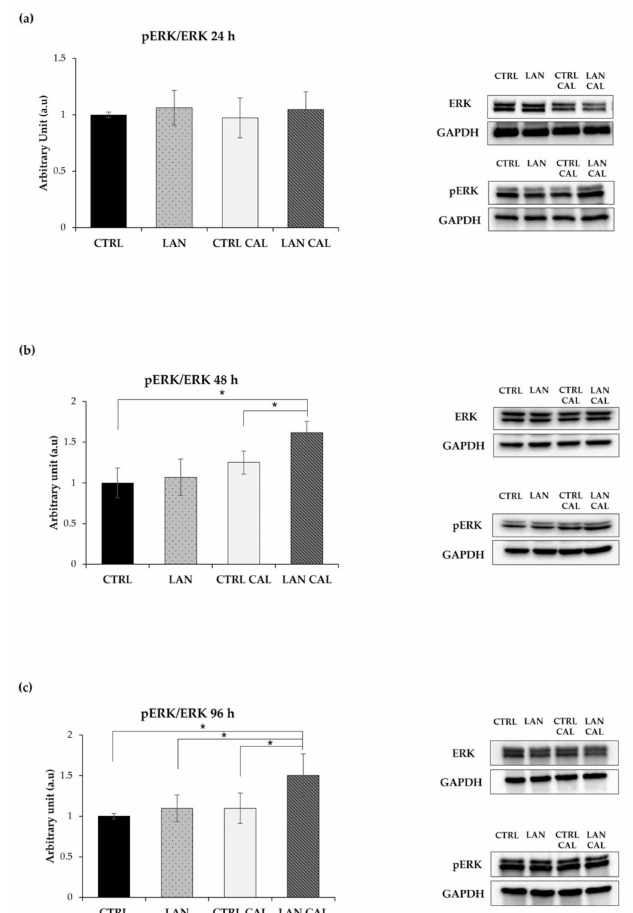
Figure 4. The effect of lanthionine alone and upon incubation with a pro-calcifying Ca 2+/ P medium on ERK phosphorylation in EA.hy926. The molecular characterization of intracellular ERK and pERK levels are expressed as a pERK/ERK ratio in endothelial cells after 1 µ M of lanthionine and 1 µ M of lanthionine with 2.8 mM of CaCl 2 and 3 mM of NaH 2 PO 4 treatment at 24 h, 48 h and 96 h. ( a – c ) Western blot analysis of pERK/ERK in endothelial cells; GAPDH is the loading control; the relative differences in protein levels shown (right of the panel) were quantitated by using Image Lab Software, normalized to GAPDH levels and expressed as a pERK/ERK ratio as arbitrary units (a.u). The untreated control is shown as a bar equal to 1. The columns represent the mean and error bars indicating the SD from three independent experiments; p -value versus untreated control = * p < 0.05, (according to Anova test). CTRL, untreated control; LAN, lanthionine; CTRL CAL, with 2.8 mM of CaCl 2 and 3 mM of NaH 2 PO 4 ; LAN CAL, lanthionine with 2.8 mM CaCl 2 and 3 mM of NaH 2 PO 4